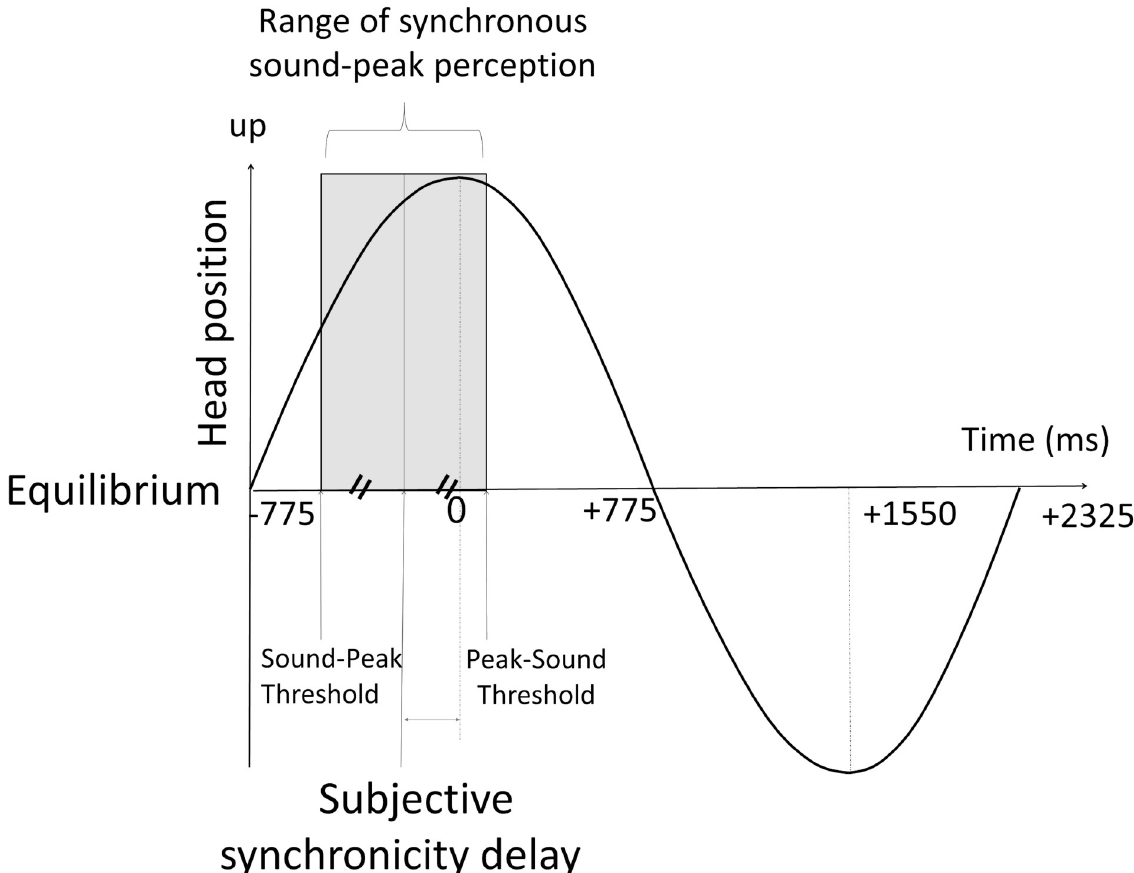
Fig 2. Relation between sound stimuli and bed oscillation. During the swinging bed-oscillations a beep was generated by the electronic device with an adjustable time lag. The zero was defined as the peak of the oscillation (head at its maximal height). The time lag was modified from -750 ms to +750 ms with 50 ms increments. Subjects were asked to indicate whether the sound and the peak are synchronous. The synchronous perception interval is depicted in gray. The upper and lower borders were measured. The middle of the range was defined as subjective synchronicity